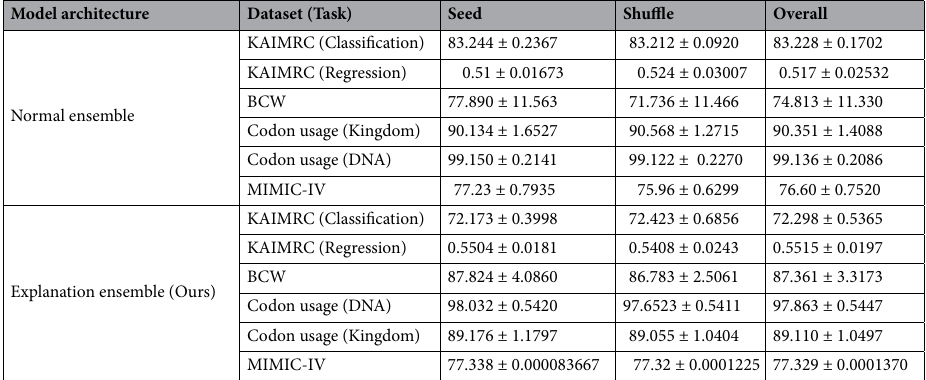
Table 3. Summary of mean accuracy/ R 2 (± standard deviation) for the normal ensemble models and explanation ensemble models (ours) when the seed and training set order is changed during